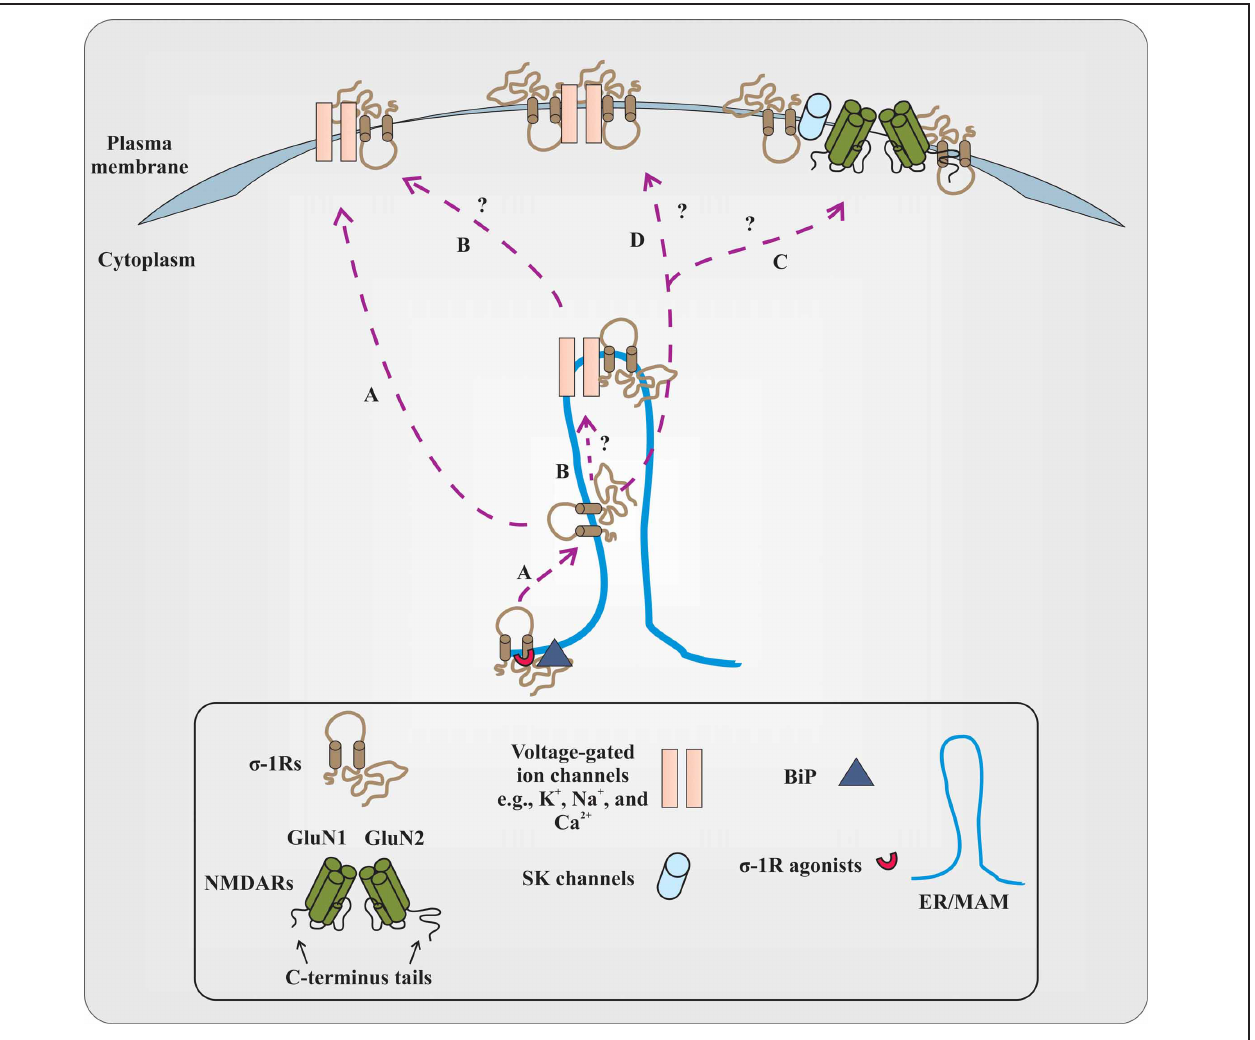
toward the plasma membrane. The study from Kourrich et al. (2013) supports this possibility, at least with voltage-gated K + -channel Kv1.2. (C) It is unclear if dissociated and translocated σ -1Rs associate with SK channels or NMDARs. The functional NMDARs are tetrameric assembles of two obligatory GluN1 subunits with either two GluN2 subunits (different combinations of GluN2 subunits) or GluN3 subunits. For representation, the dimer form of NMDARs (GluN1 and GluN2 subunits) and their C-terminus tails are presented in the figure. The N-terminus domain of NMDAR subunits and GluN3 subunits are not shown. (D) The other possibilities that remain unexplored are whether the dimers of the σ -1R interact with ion channels, and the stoichiometry of interaction between the σ -1R and ion